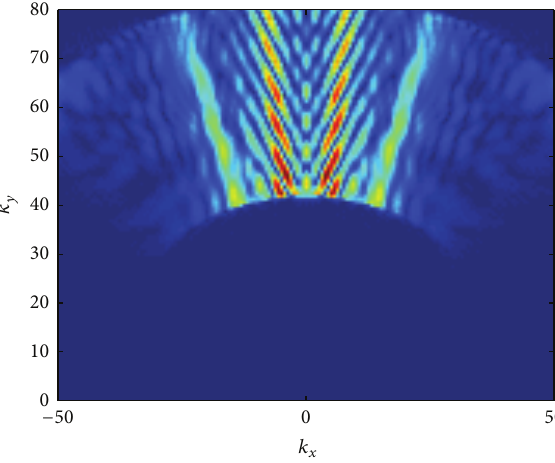
Figure 14: The spatial spectrums for the three targets overlap largely when we take the 2D Fourier transform of the whole image